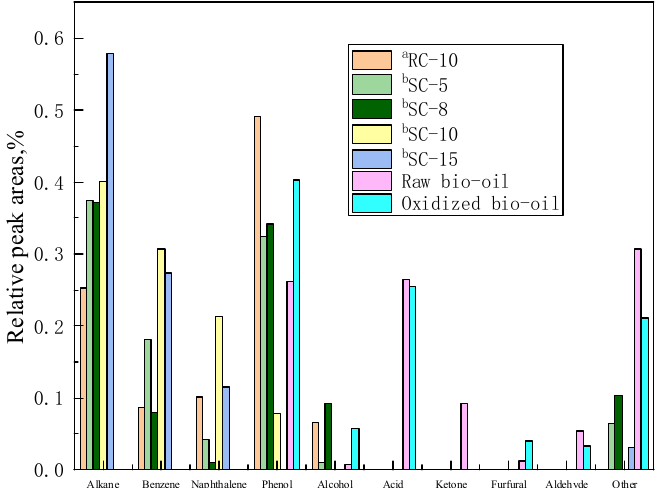
Figure 1. GC/MS analysis of raw bio-oil, oxidized bio-oil, and organic liquids (RC-10 and SC-X) obtained from the hydrodeoxygenation of oxidized oil using different catalysts. Note: a RC-10 means organic liquids produced from oxidized bio-oil upgrading with 10 wt% reduced CoMo/ γ -Al 2 O 3 as the catalyst; b SC-X means organic liquids produced from oxidized bio-oil upgrading with sulfided CoMo/ γ -Al 2 O 3 as the catalyst; X represents the catalyst loading ratio (wt%).